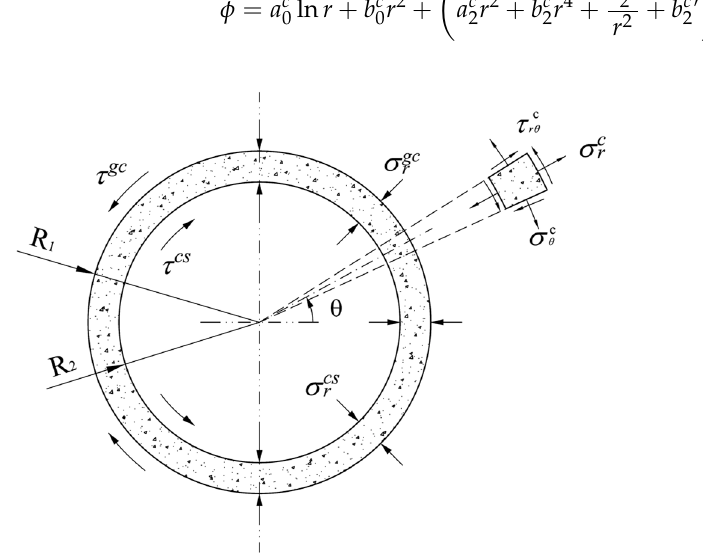
Figure 5. An illustration of stress condition in the concrete tunnel lining.